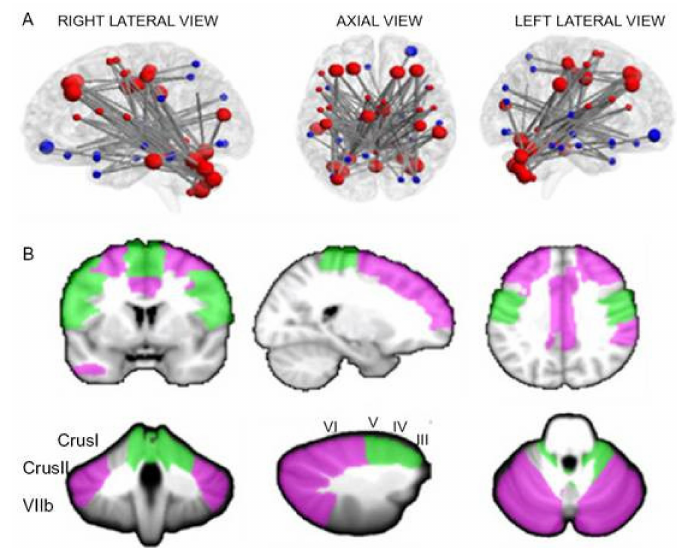
Figure 6. ( A , B ). Panel A shows the network of significantly decreased functional connectivity in 9 SCA2 patients compared to 33 healthy controls as assessed by network-based statistics analysis. The regions of the cerebello-cortical (red) and cortico-cortical (blue) modules are shown in di ff erent colors. Bigger nodes correspond to cerebellar and cortical regions relevant to cognition and emotion; smaller nodes correspond to cerebellar and cortical regions relevant to motor control. Panel B shows the anatomical representations of cognitive (violet) and motor (green) nodes in the cerebellum and cerebral cortex showing underconnectivity between each other. Reproduced from Olivito G, Cercignani M, Lupo